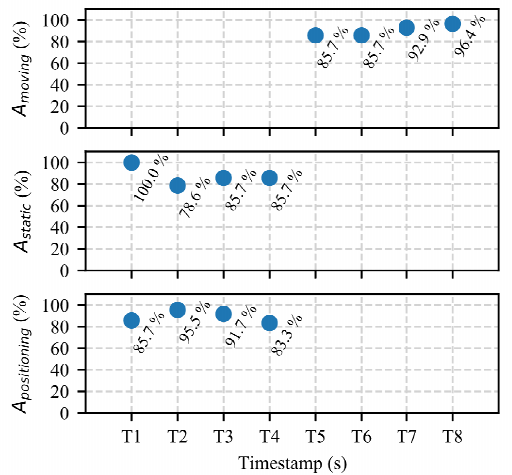
Fig. 9. Accuracies obtained by k NN classifier